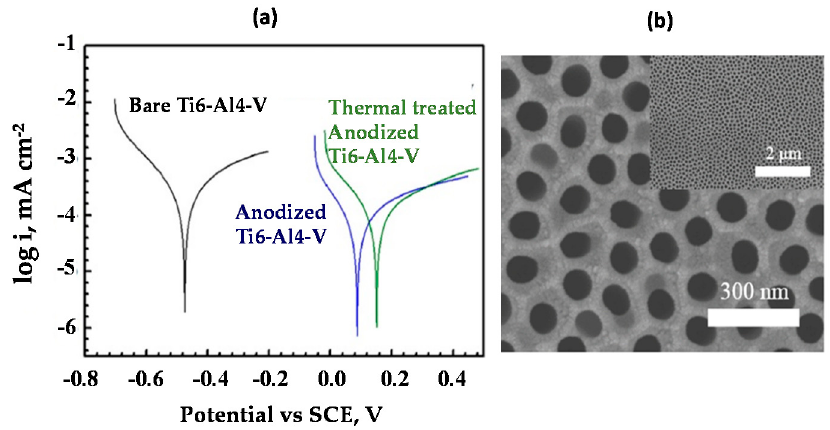
Figure 12. ( a ) Evans’s diagram of three Ti-6Al-4V samples in 8 g/l NaCl solution. ( b ) FE-SEM micro- graph of a nanoporous oxide grown on Ti-6Al-4V at 100 V in ethylene glycol electrolytes, NH 4